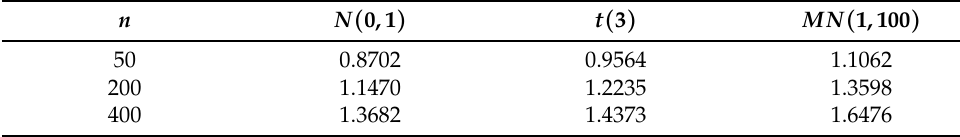
Table 5. CPU times for different n in Example